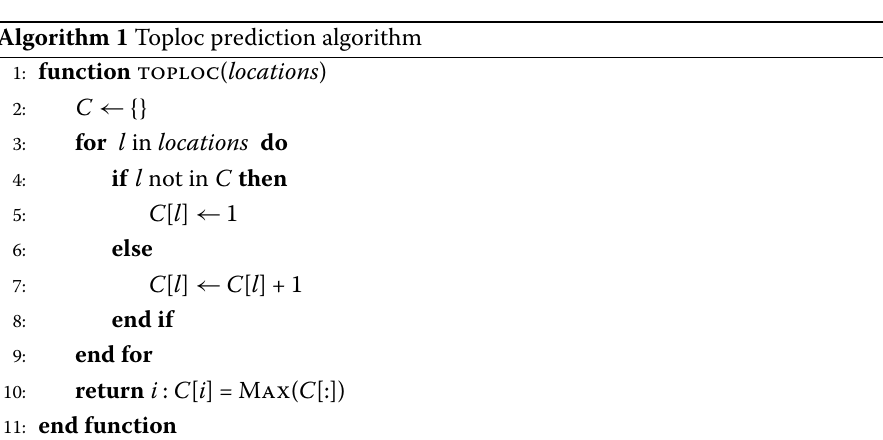
Algorithm 1 Toploc prediction